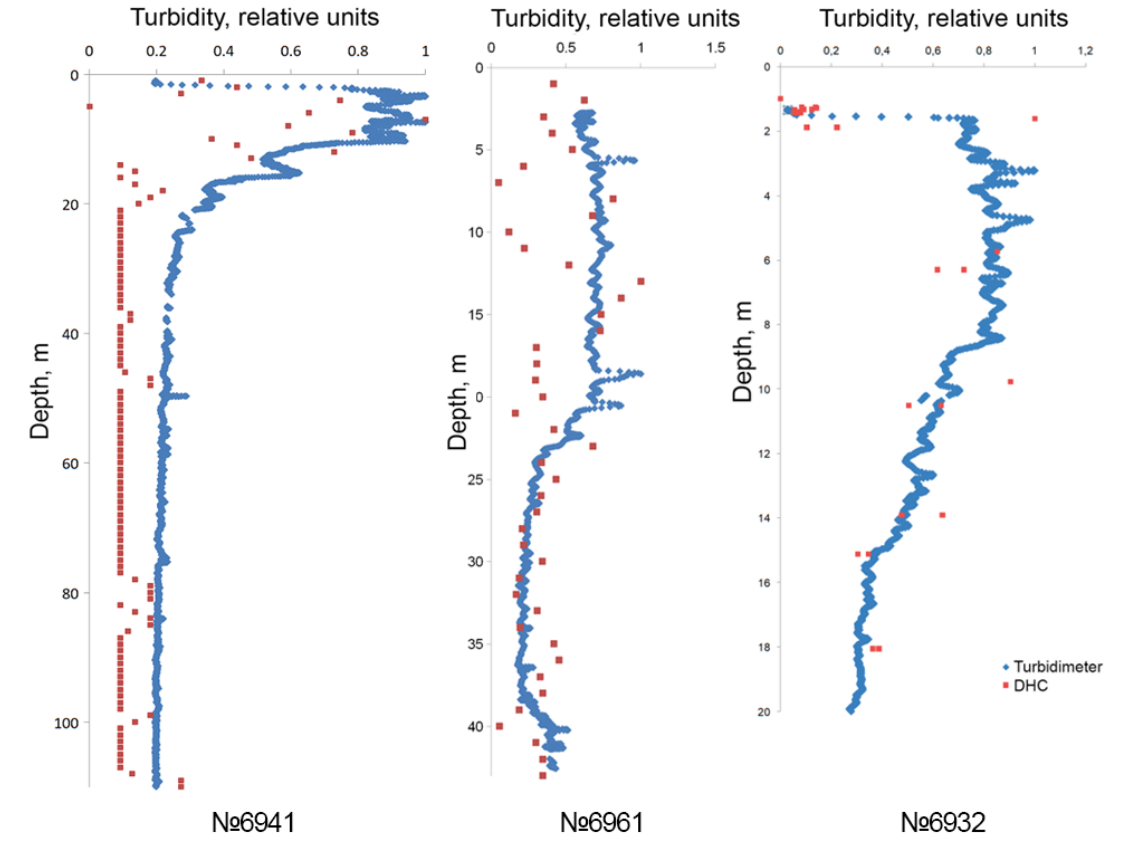
Figure 13. Turbidity results using the DHC technology (red dots) and a standard turbidimeter (blue dots).